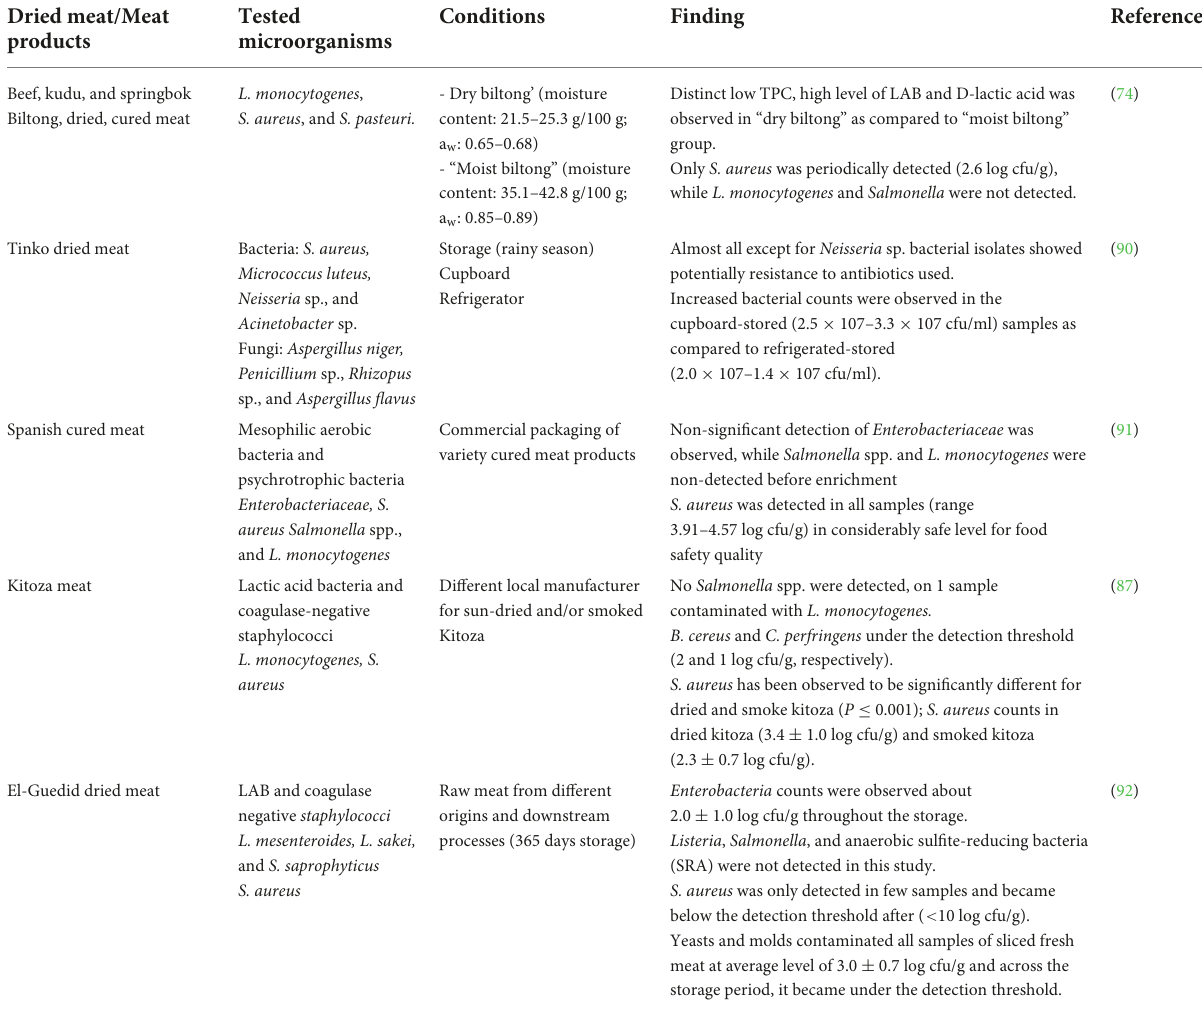
TABLE 5 The table summary of microbiological characterization of dried meat and meat products from various processing conditions, storage, packaging, and localities. Dried meat/Meat